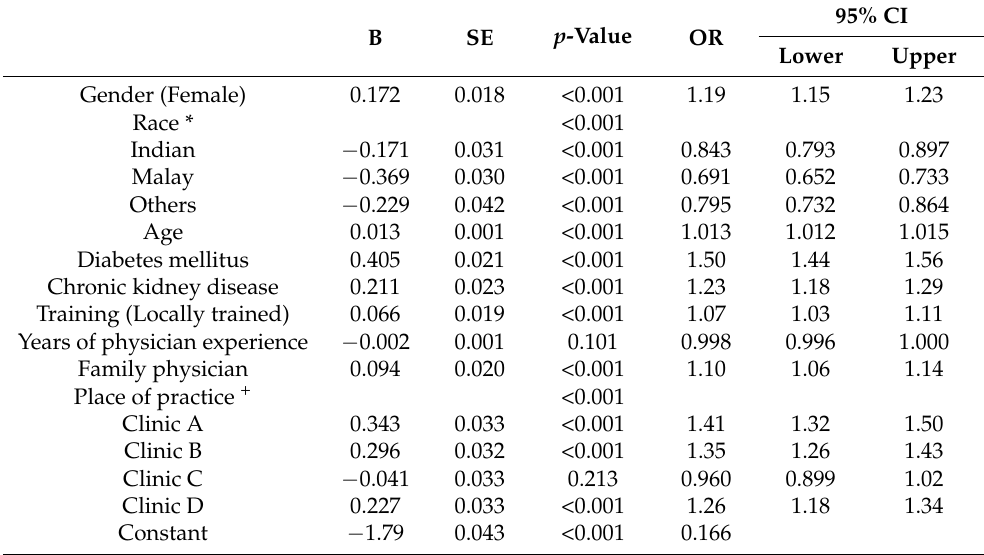
Table A5. Multivariate logistic regression for factors contributing to topical skin antibiotics with irrelevant diagnoses, 2018–2021.